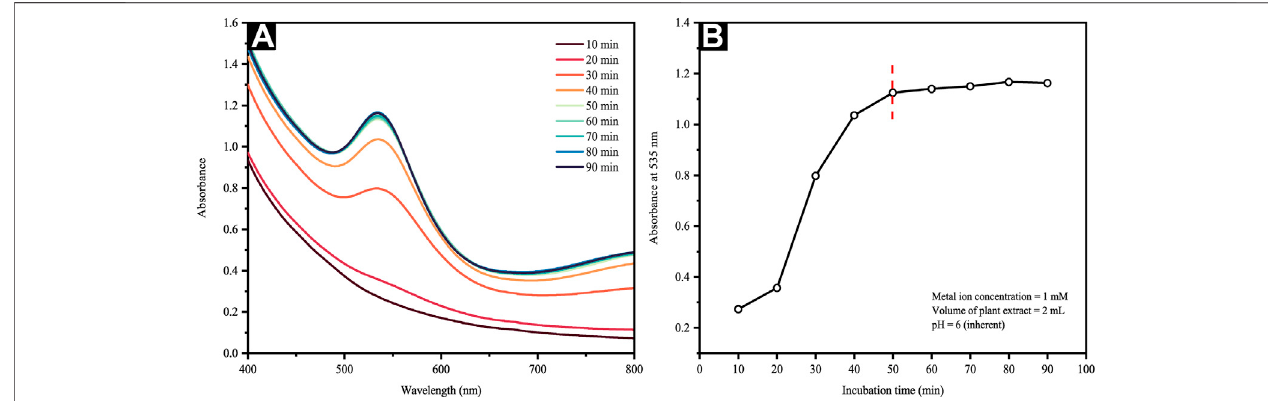
FIGURE 1 | (A) UV-Vis spectra of the reaction mixture at different time intervals and (B) change in absorbance of Au colloidal solution at 535 nm as a function of time.